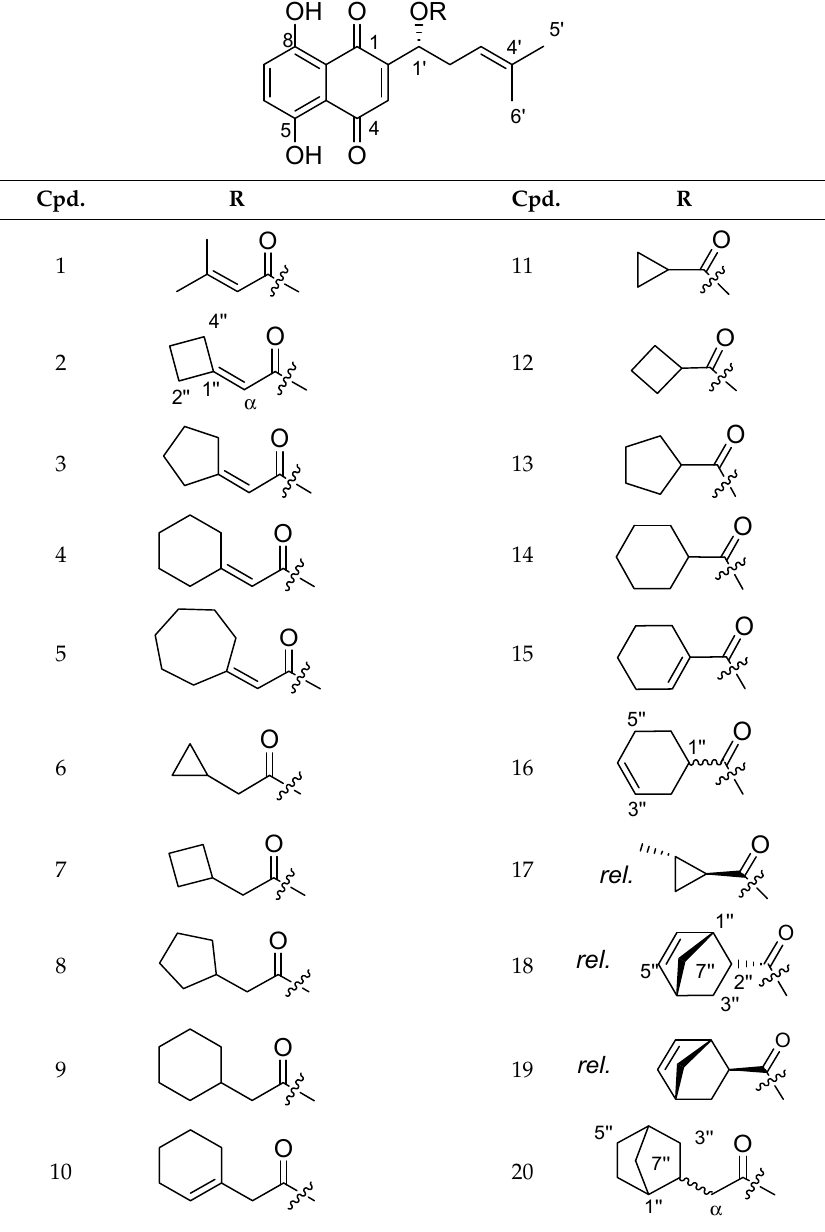
Table 1. List of investigated shikonin esters. Cpd.